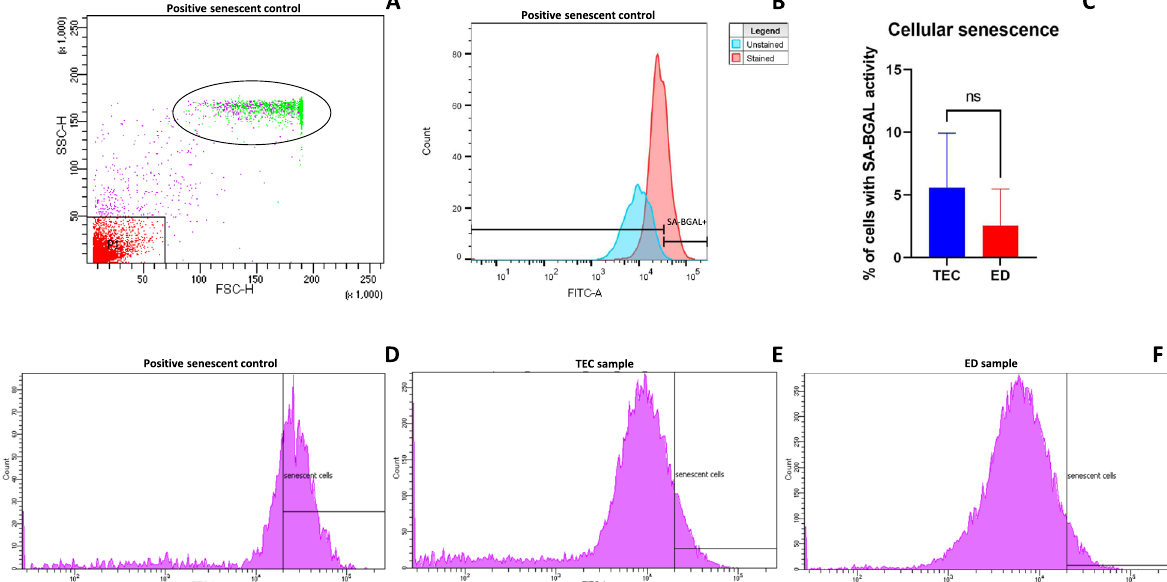
Fig. 5 Cellular senescence evaluated by senescence associated-β-galactosidase (SA-BGAL) activity. SA-BGAL activity of cryopreserved microfragmented adipose tissue (AT) when analyzed quantitatively using flow cytometry at passage 4. ( A ) Forward (FSC-A)- and side-scatter (SSC-A) plot of senescent positive control sample (see Methods). P1 gating was used to remove debris and gate on non-P1 cells. Green colored cells (marked by ellipse) show backgating of identified senescent cells of large size and high granularity. ( B ) FITC histogram of unstained and stained positive control senescent cells used for SA-BGAL activity gating. ( C ) Box plot of the quantity (%) of cells with SA-BGAL activity from cryopreserved microfragmented AT when isolated with tissue explant culture (TEC) or enzymatic digestion (ED). ns: non-significant when analyzed with a paired t-test. ( D ) Histogram showing gating of SA-BGAL cells as a measure of senescence from the senescence positive control. ( E ) Representative + histogram showing SA-BGAL cells as a measure of cellular senescence from cryopreserved microfragmented AT when isolated by TEC, and ( F ) + when isolated by